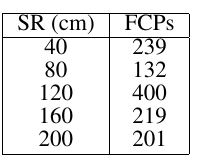
Figure 9. Aerial and LiDAR FCPs in yellow (200 cm)